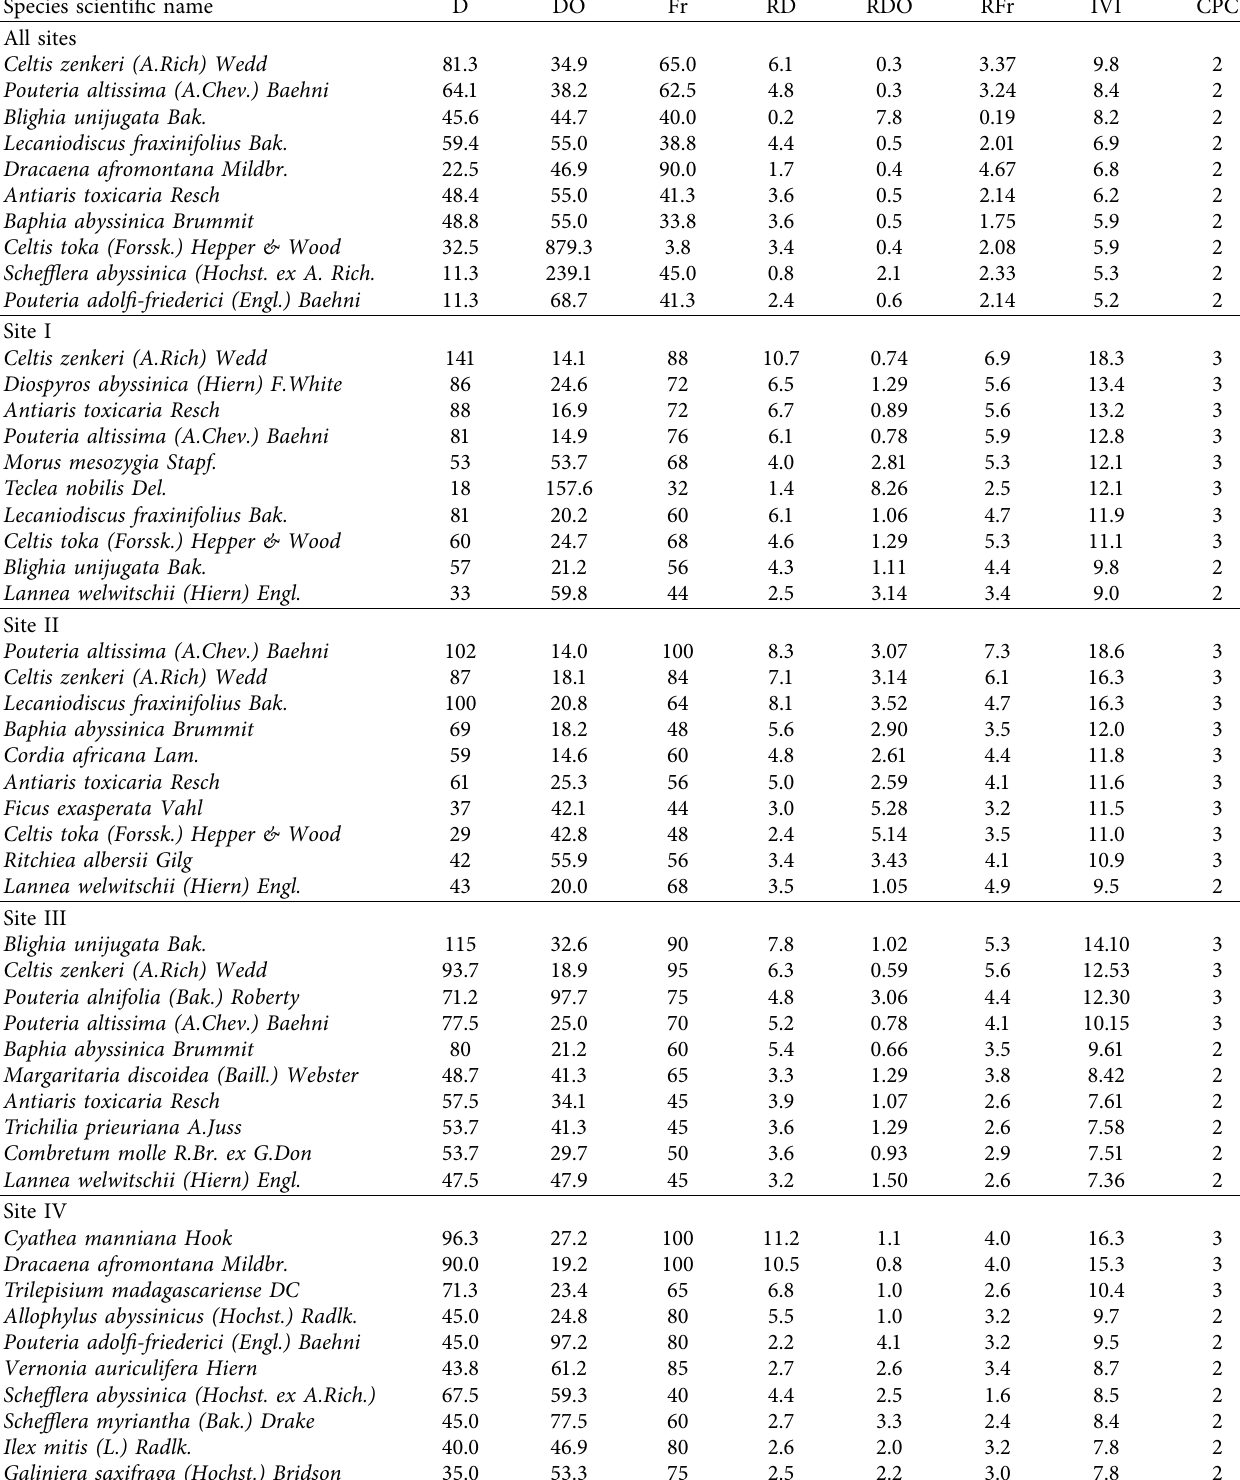
Table 7: The top ten species with the highest IVI value in all the sites of